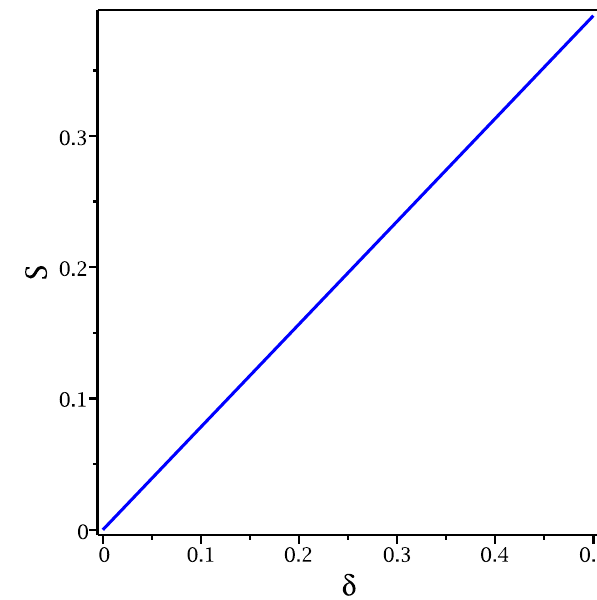
Fig. 6 The energy E vs thickness δ . We have chosen σ 0 = 4, D = 1, A 0 = 1, (cid:8)(ε) = − 1, m = 2 and H (ε) = 1 . 1